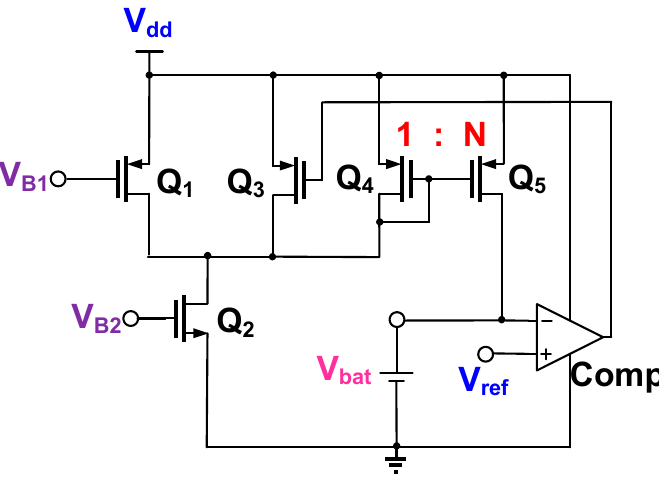
Figure 7. Complete circuit of the low-voltage LDO regulator.